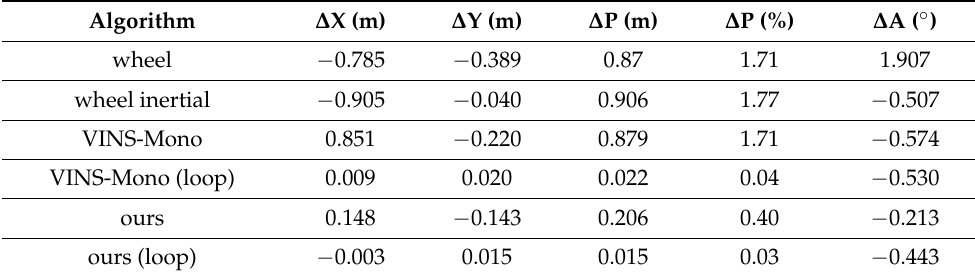
Table 1. Room-scale pose measurement